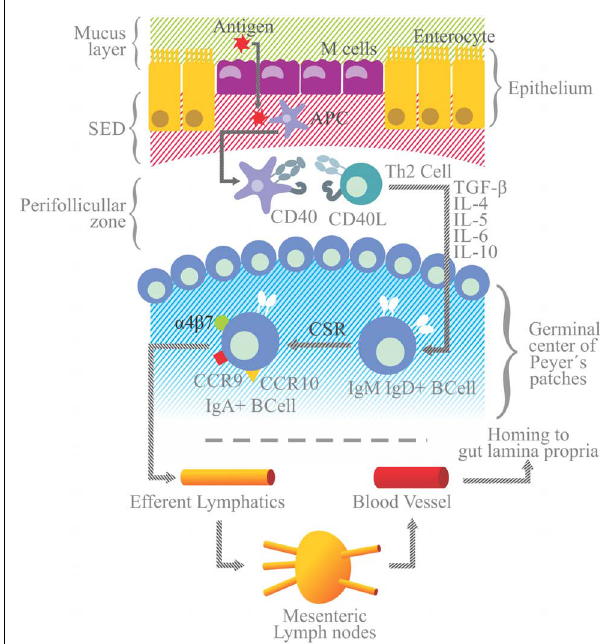
FIGURE 3 | Simplified model of IgA generation. Antigen presenting cells and dendritic cells are located in the subepithelial dome (SED) beneath M cells. After sampling, luminal antigen is processed and expressed on the surface as an antigen-derived peptide associated with the MHC-II molecule. Dendritic cells with the MCH II peptide and the CD40 antigen on the surface migrate to the perifollicular zone of Peyer’s patches to interact withTh2 lymphocytes endowed withTCRs and CD40 ligand (CD40L) on their surface. Immunological synapsis between APC andTh2 cells via the binding of the MHC-II peptide toTCR and of CD40 to CD40L leads to the activation ofTh2 and the release ofTGF- β . Along with signals elicited by the CD40/CD40L binding,TGF- β is aTh2-derived IL essential for the class switch recombination of IgM + B cells to generate IgA + B cells, occurring in the germinal center of Peyer’s patches (highlighted in blue). OtherTh2 ILs (e.g., IL-4, -5, -6, and -10) favor the differentiation and maturation of IgA + B cells into IgA + plasma cells. IgA + B lymphocytes acquire the expression of gut-homing receptors, such as α 4 β 7, CCR9 and CCR10, and migrate toward efferent lymphatic vessels and mesenteric lymphoid nodules. From there they can reach the blood stream and migrate to the lamina propria (the gut effector site). Gut epithelial cells express the MadCAM1 ligand for α 4 β 7, and release CCL25 and CCL28, chemokines that are ligands for the CCR9 and CCR10 receptors,